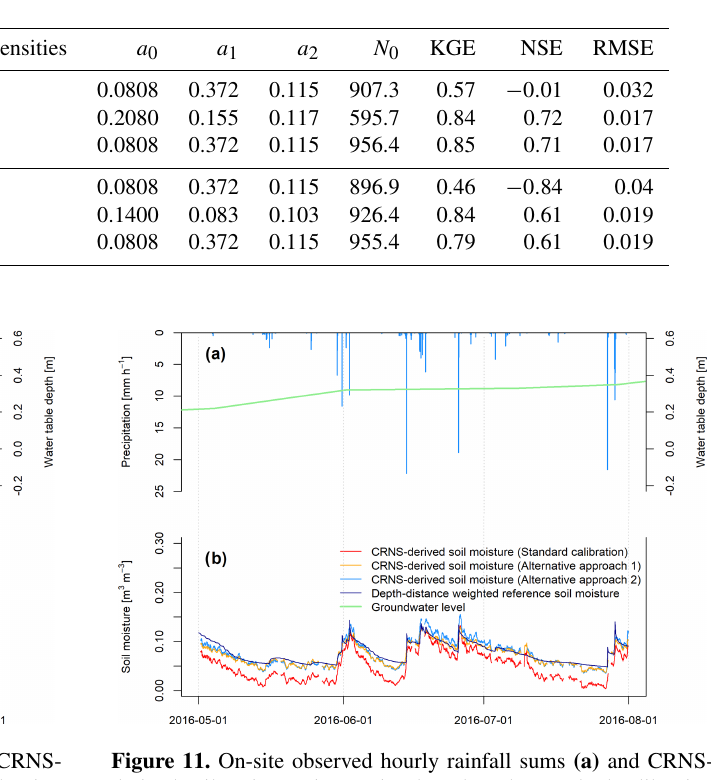
Table 2. Statistical goodness of fit when calibrating Eqs. (2)–(5) with (applying) the three different calibration approaches.